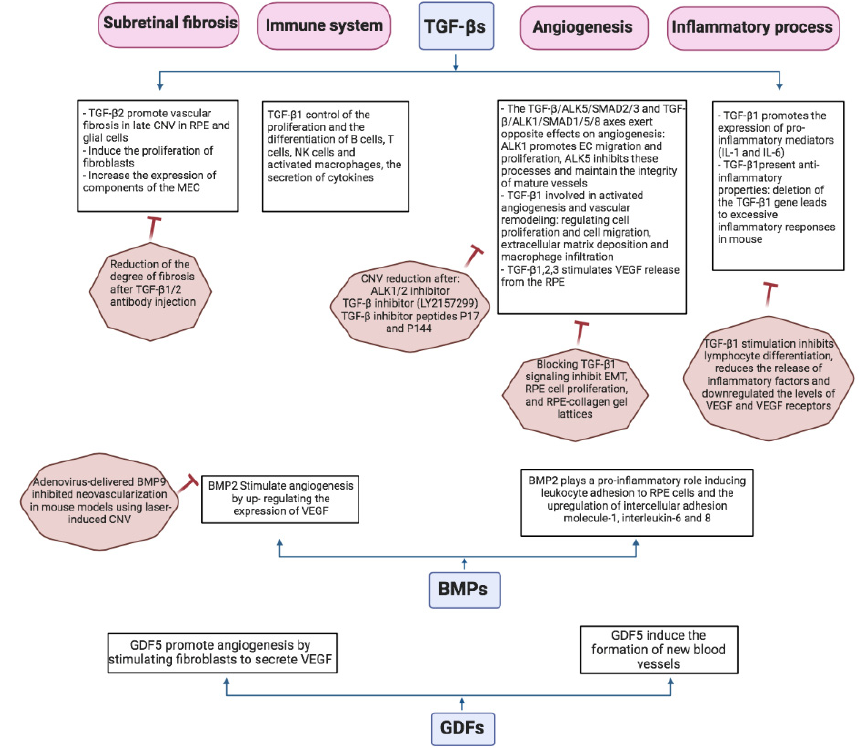
Figure 3. Functional implications of TGF- β signaling in pathological processes underlying age- related macular degeneration. Description of the mechanisms of TGF- β superfamily in CNV and wet AMD, including the modulation of angiogenesis-related factors, inflammation, vascular fibrosis, and immune responses. EC: endothelial cell. ECM: extracellular matrix proteins. MET: mesenchymal transition. RPE: retinal pigment epithelium. CNV: choroidal neovascularization.